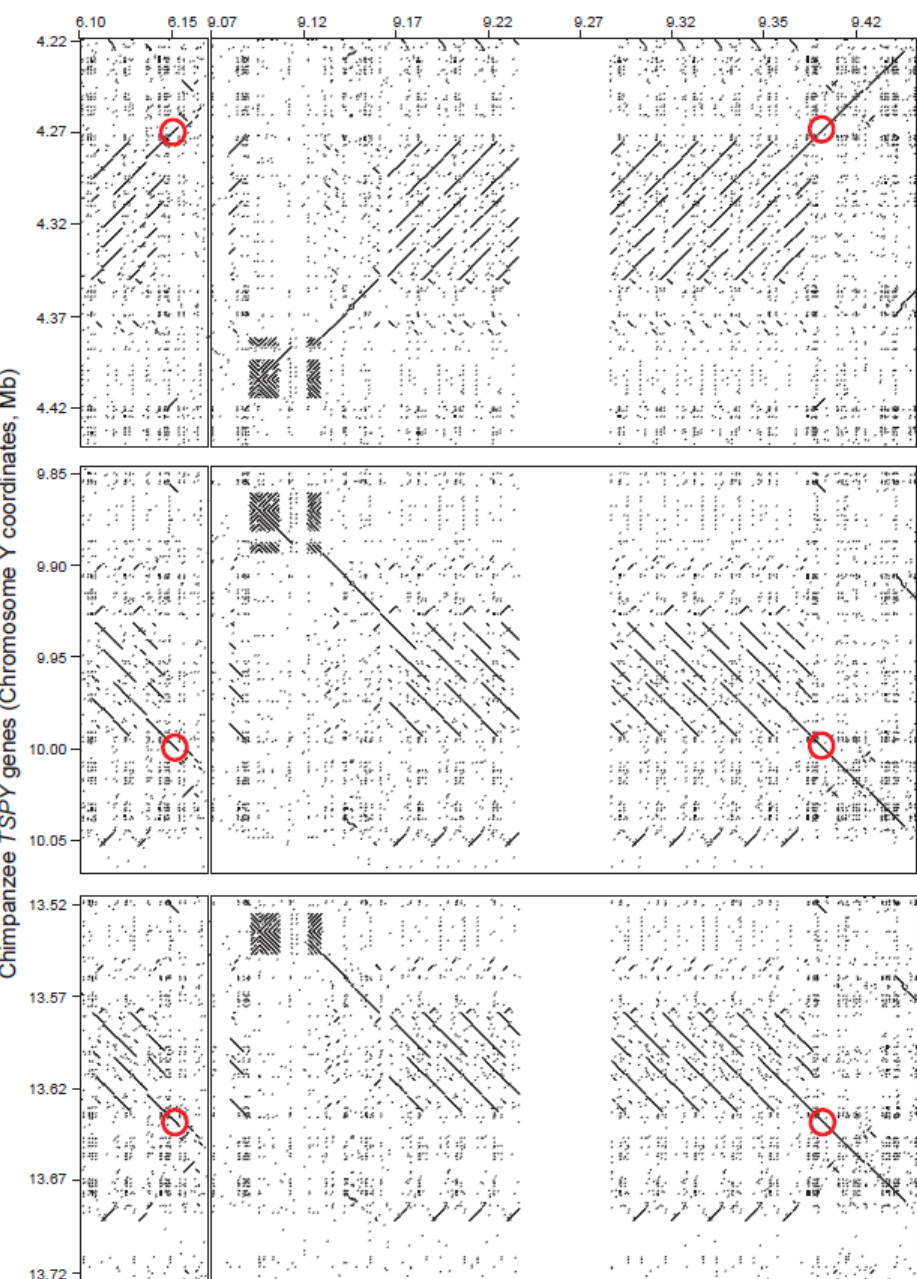
Figure 1. Comparison of human and chimpanzee gene clusters. Left panels, human TSPY minor cluster at 6.1 Mb; right panels, human TSPY major array at 9.1–9.4 Mb including assembly gap shown as a blank region (GRCh37). Top panels, chimpanzee TSPY cluster 1 at 4.3 Mb (4 genes); middle panels, chimpanzee TSPY cluster 2 at 9.9 Mb (1 gene); bottom panels, chimpanzee TSPY cluster 3 at 13.6 Mb (1 gene) (panTro2). Red circles indicate the region analyzed in Figure